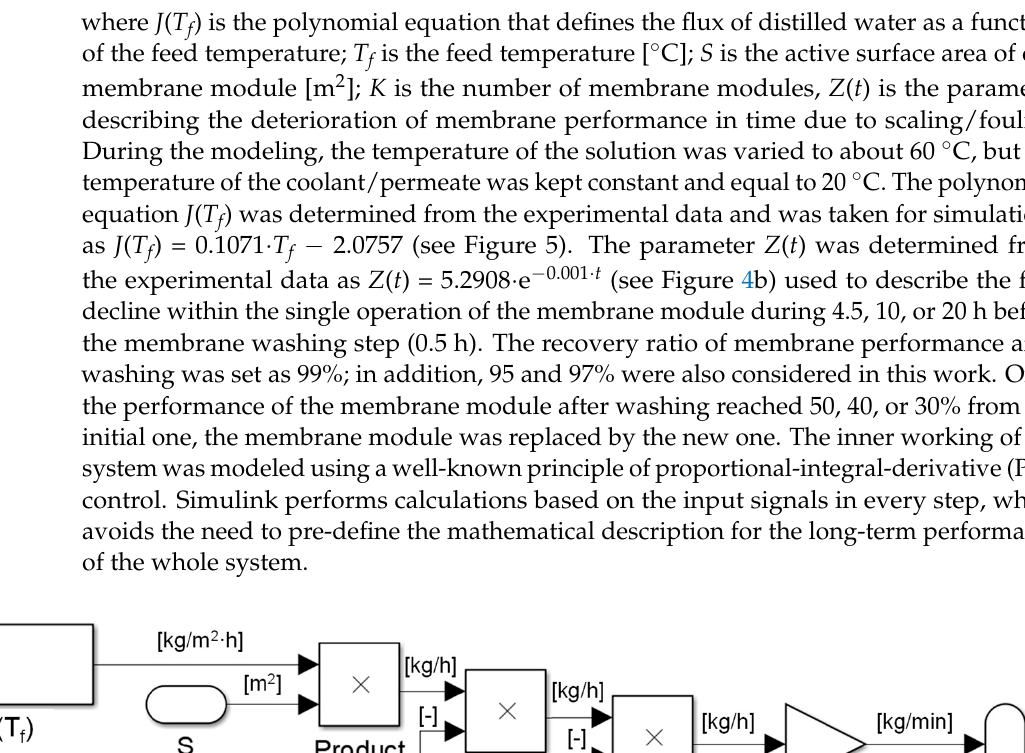
a b Figure 4. Experimental performance of AGMD-MC module. ( a ) permeate fluxes and de- crease of the membrane performance in two runs; ( b ) exponential approximation of the permeate drop by combined first and second runs. Initial feed concentration 10 wt.% NaCl, hot circuit temperature 60 °C, cold circuit temperature 20 °C, d = 3 mm. 3. Results and Discussion 3.1. AGMD-MC Experiments Figure 4a shows typical experimental permeate fluxes and a decrease of the membrane performance over time due to reversible and irreversible fouling (hot circuit temperature 60 °C). The initial feed concentration in our experiments was 10 wt. % of NaCl, and it became saturated after ~60 min. The module was flushed for